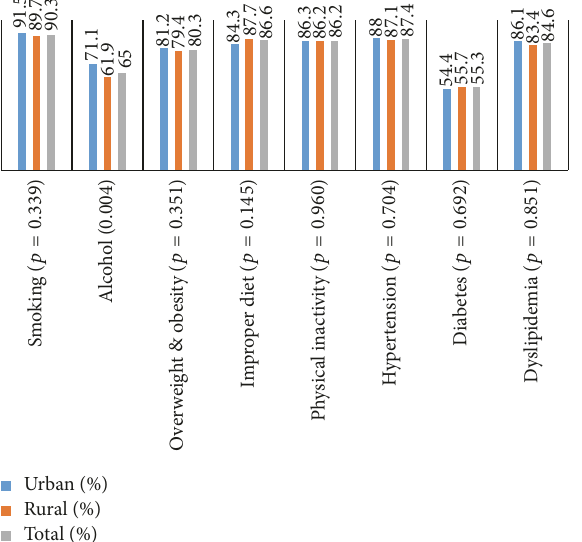
Figure 2: Awareness of modifiable CVDs risk factors among the study participants.